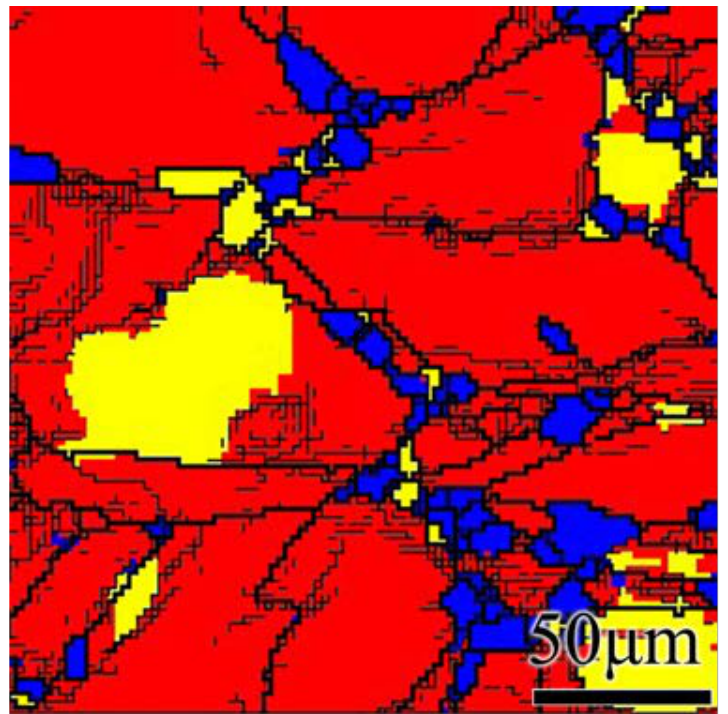
Figure 9. Microstructure of the specimens deformed to a 0.4 effective strain at 1040 ° C (red, yellow, blue represent deformed, sub-structured and recrystallized grains respectively).